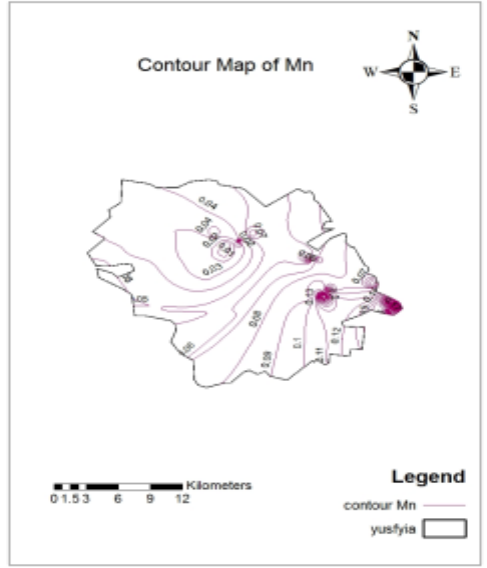
Fig.20: The interpolation and contour line of Mn map in